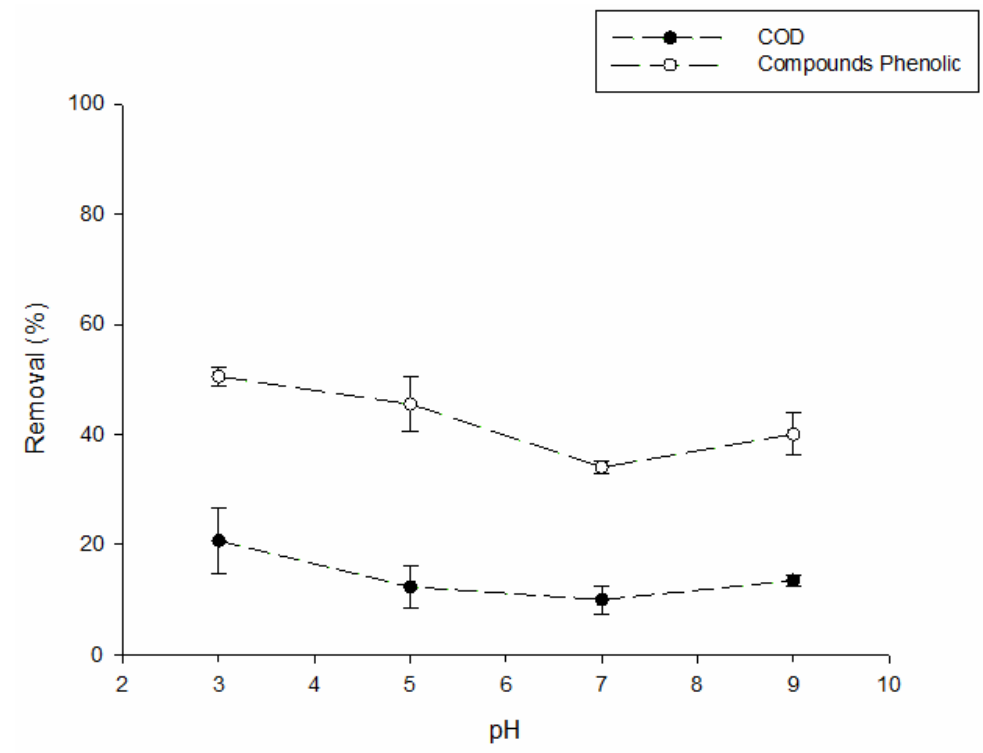
Figure 7 . Initial pH influence on COD and phenolic compounds removal in study PMS activated by US (1600 mg/L of PMS after 15 min of reaction) .